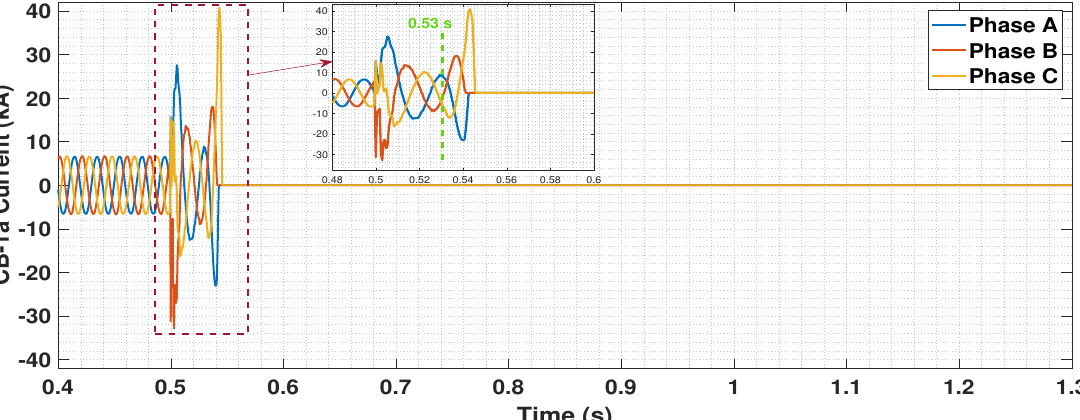
Figure 31. Currents in circuit breaker (CB-1a) upon three-phase line to ground fault in the middle of cable-1.